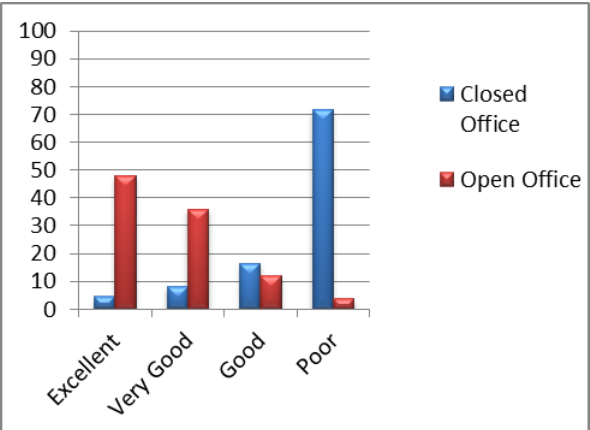
Figure 2. Level of communication of employees within a group. Source:( Author, 2012).